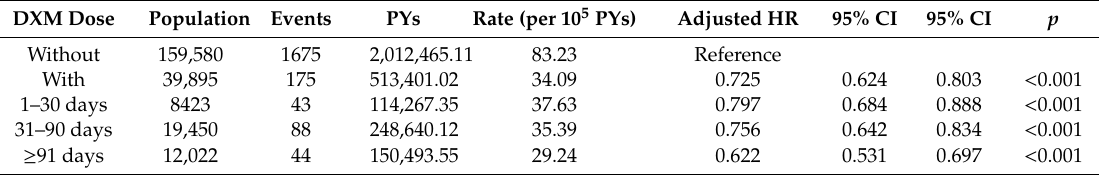
Table 2. Factors of hearing loss among di ff erent duration of DXM by using Cox regression.